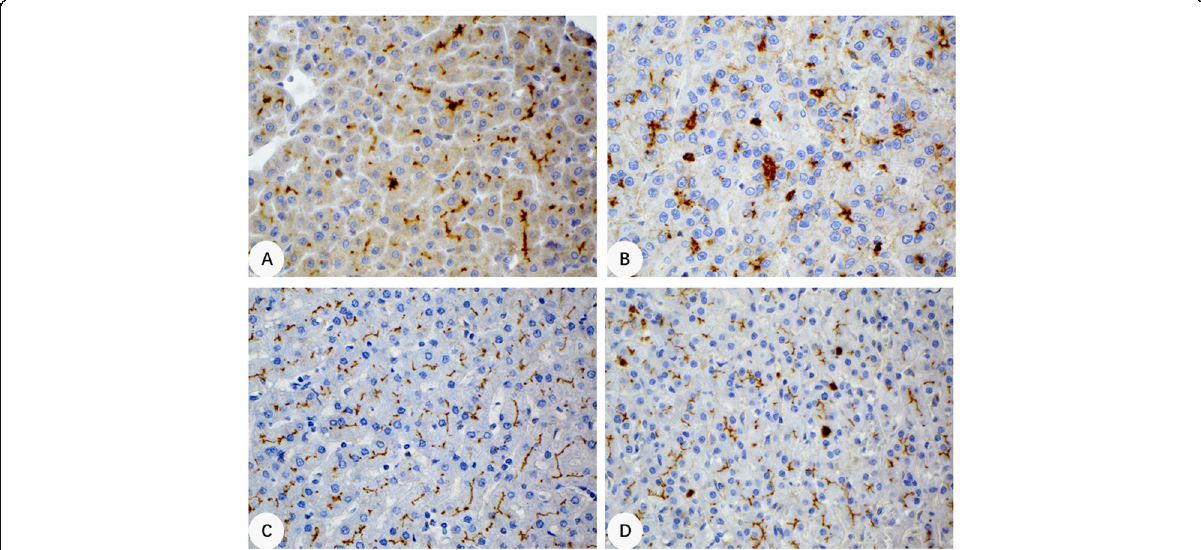
Fig. 3 Immunohistochemical staining patterns of CD10 and pCEA. a , Enhanced CD10 canalicular staining seen in a HCC (400x). b , Enhanced pCEA canalicular staining in a HCC (400x). c , Linear canalicular staining pattern for CD10 in nonneoplastic liver tissue (400x). d , Linear canalicular staining pattern for pCEA in nonneoplastic liver tissue (400x). Positive staining was also noted in scattered inflammatory cells for